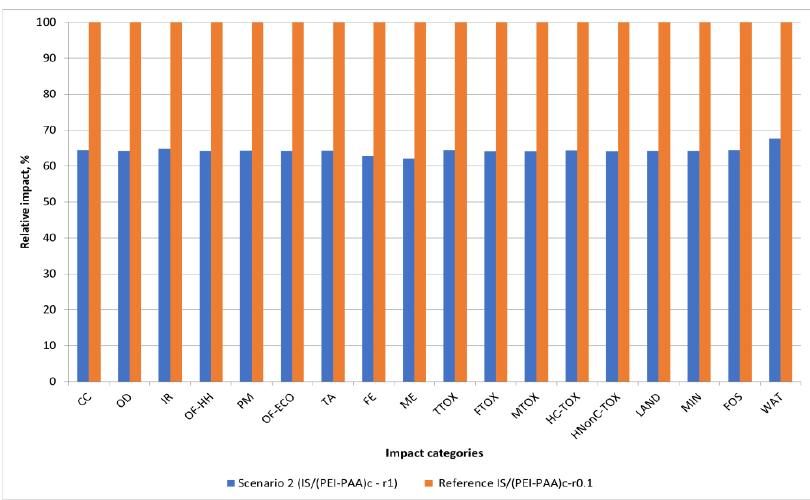
Figure 6. Scenario 2 vs. the reference case comparison of environmental impacts.